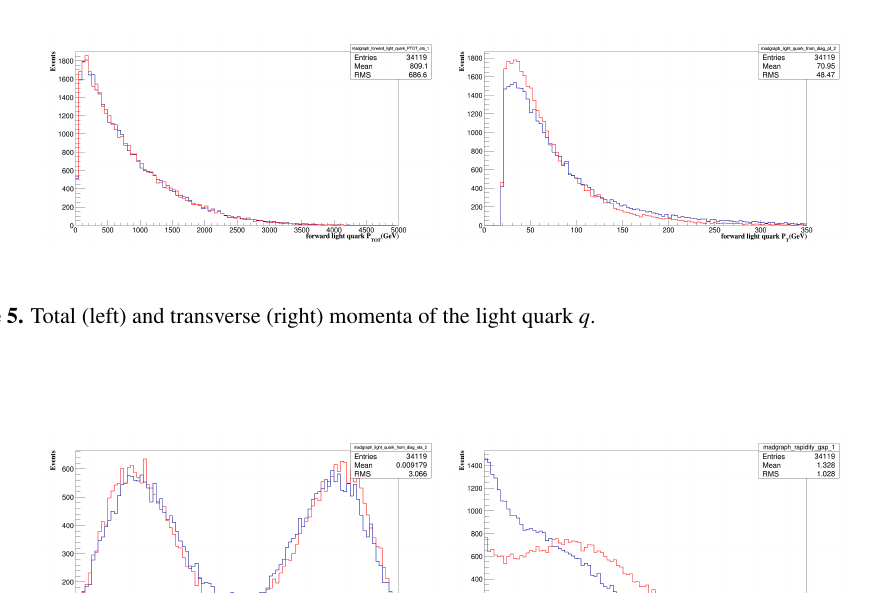
the very high rapidity values. Finally, Fig.6 (right) shows the “rapidity gap”, i.e. di ff erence in rapidity between the light quark q and the nearest b-quark from either Higgs or top decay. There is a significant di ff erence between SM and ITC in the rapidity gap distribution. However, in both cases the value of the rapidity gap is significantly larger than zero.